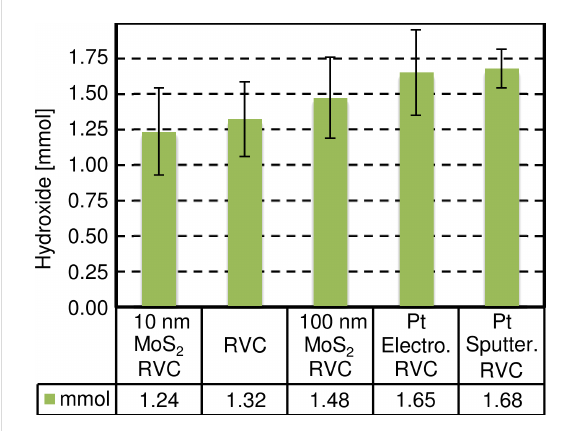
Figure 9: Average hydroxide (OH–) moles produced during the 2 h ex- periments.